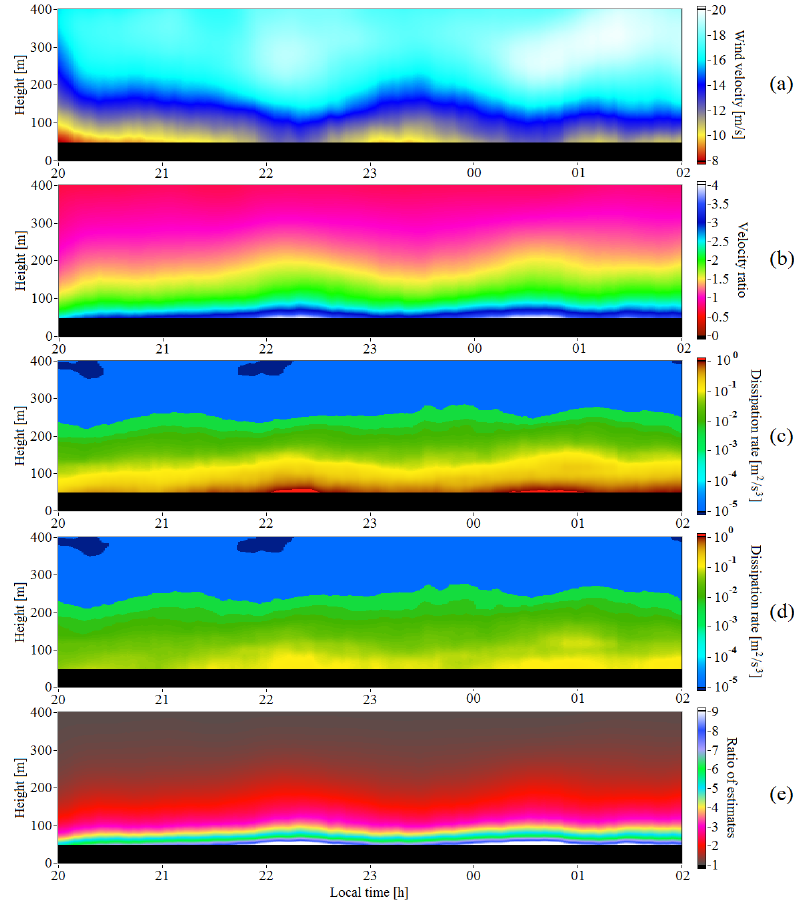
Figure 4. Height–temporal distributions of the mean wind velocity ( a ), ratio of the mean wind velocity to the linear scanning speed µ ( b ), estimates of the turbulent energy dissipation rate obtained by Methods 1 ( c ) and 2 ( d ) and the ratio of these estimates ( e ). Measurements were taken on the coast of Lake Baikal from 19:45 LT of 19 August to 02:15 LT of 20 August 2019.